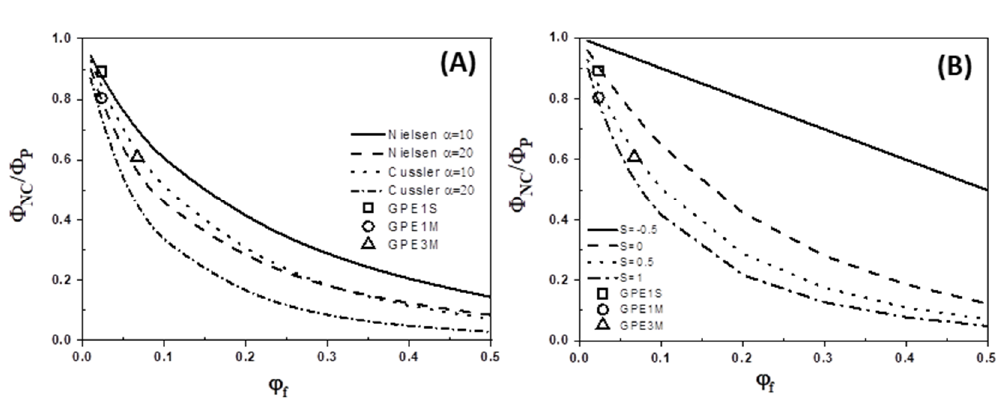
Figure 12. ( A ) E ff ect of aspect ratio of graphene layers on the barrier properties of nanocomposites as a function of the filler volume fraction for Nielsen and Cussler models. Experimental data of GPE1S, GPE1M, and GPE3M are also represented, using Φ P = 1.02 Barrer. ( B ) Comparison between experimental permeability for GPE1S, GPE1M, and GPE3M with the model predictions from Equation (22), with Φ P = 1.02 Barrer, α = 10 for di ff erent values of tortuosity parameter, S .